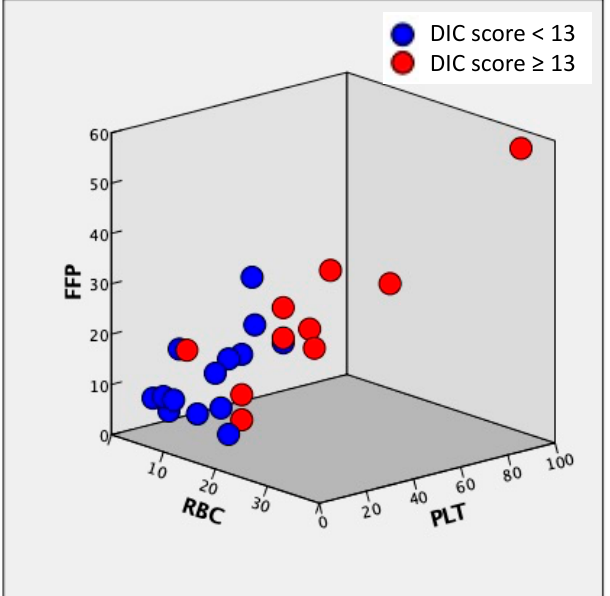
Figure 3. Correlation of RBC, FFP, and PLT. RBC, red blood cells; FFP, fresh frozen plasma; PLT, platelet. The amount of RBC, FFP, and PLT transfusions is described by Japanese units, which is defined as that derived from 200 mL whole blood.